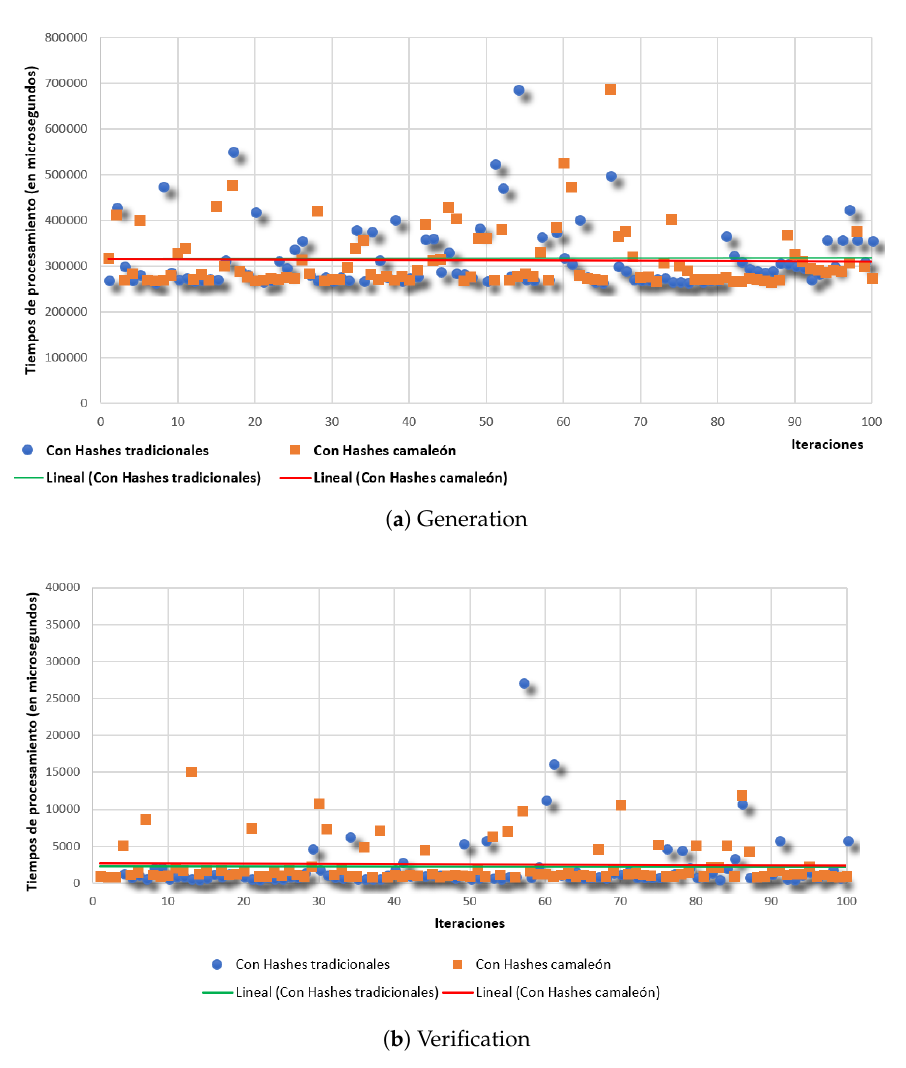
Figure 3. Processing time (in microseconds) traditional signature vs chameleon hashes (100